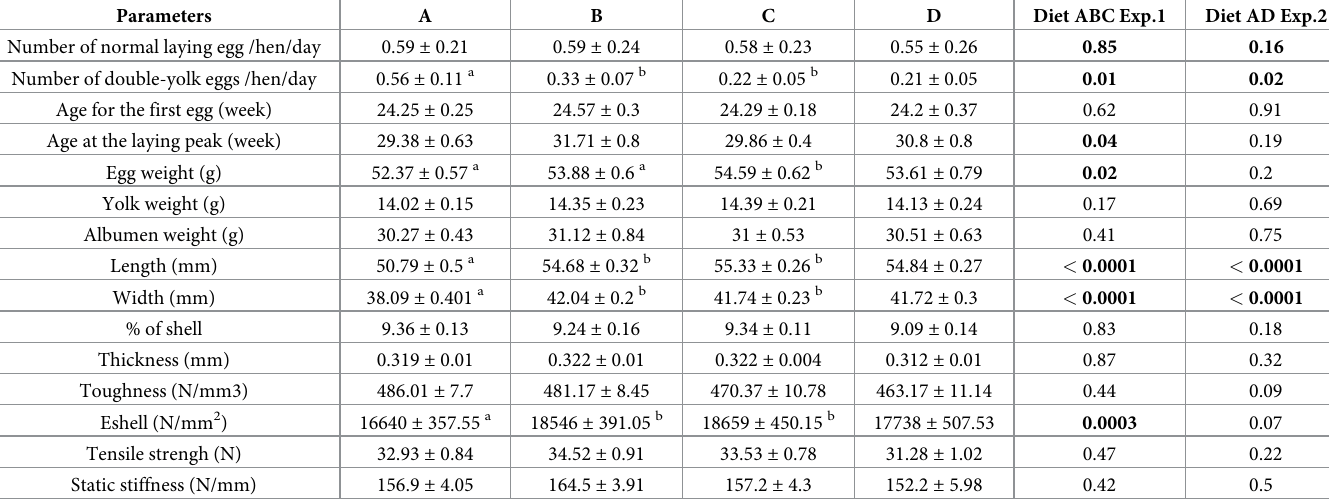
Table 1. Number and quality of laying eggs of broiler hens fed with a GSE diet supplemented. Group A: animals fed with control diet without GSE supplementation, B and C: animals supplemented with GSE at 0.5% and 1% of the total diet composition, respectively, starting at 4 week-old until 40 week-old and D: supplementation at 1% of the total diet composition starting at hatch until 40 week-old.